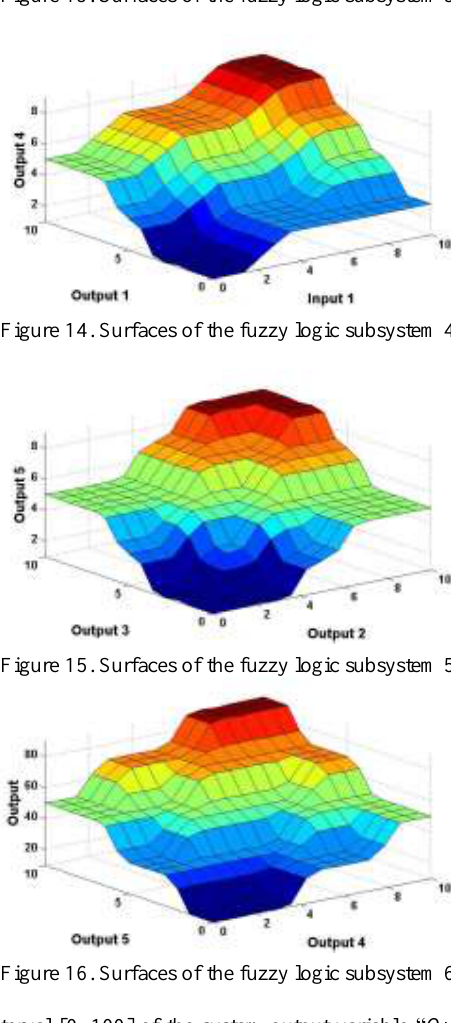
Figure 13. Surfaces of the fuzzy logic subsystem 3.